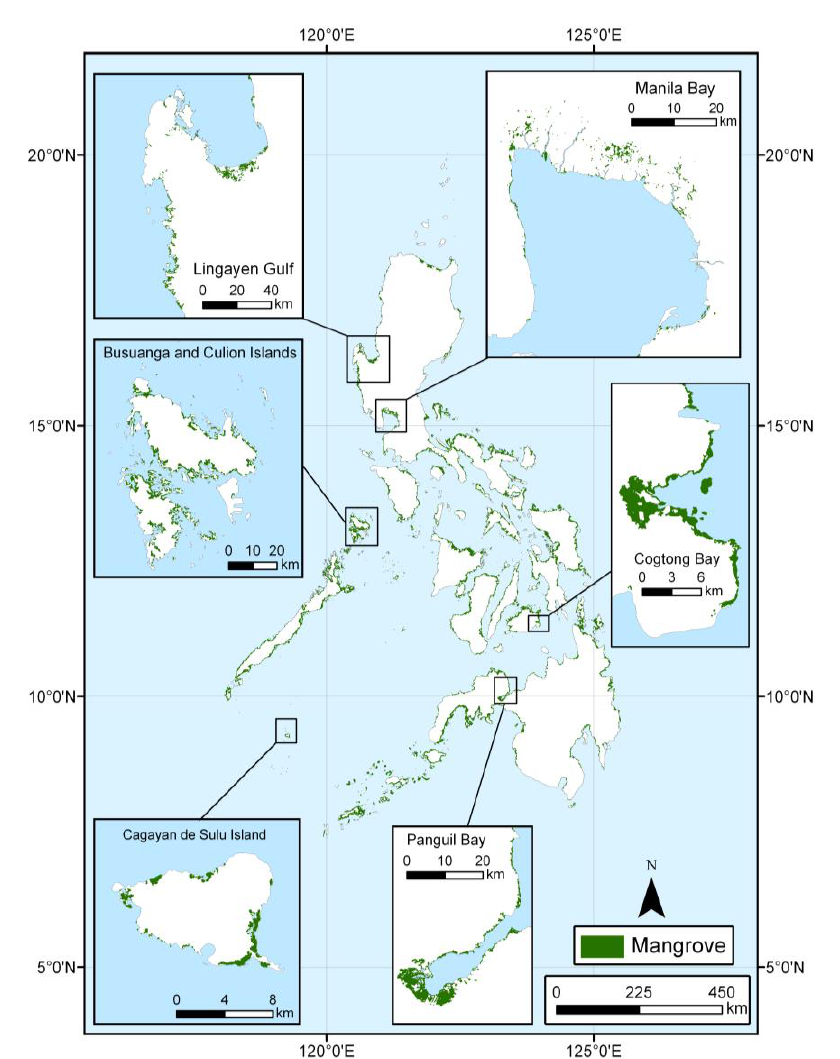
Figure 5. Spatial distribution of mangrove forests of the Philippines for 2000.